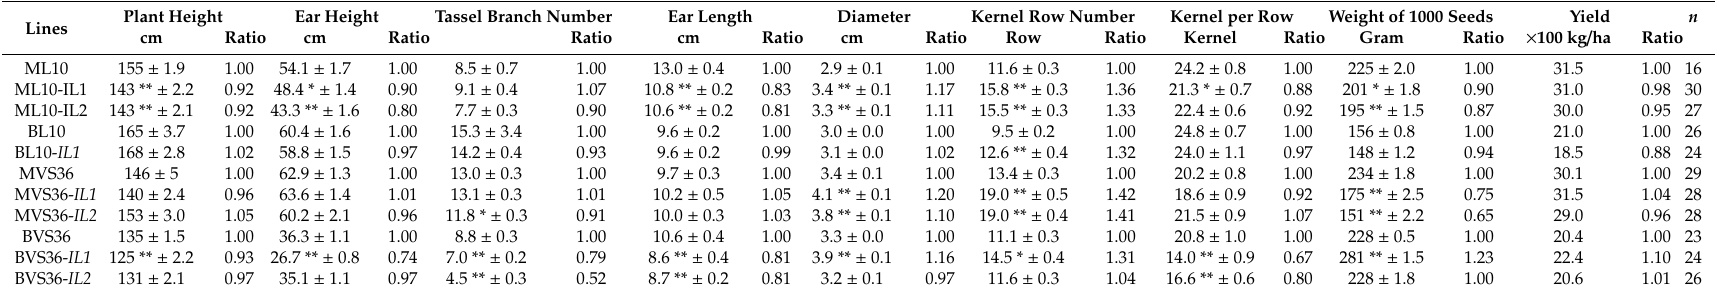
Mean value ± standard error of the mean (s.e.m) is shown in real value units; the ratio was calculated over the value of the corresponding parent. n —least number of plants used for the measurements except for the weight of 1000 seeds ( n ≥ 3). *, ** indicate significantly di ff erent compared to the recurrent parent (Student’s t -test, p -value < 0.05 and 0.01,